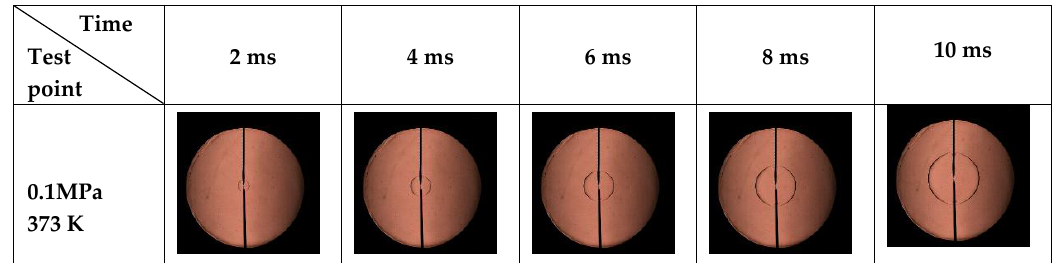
Figure A1. Schlieren photographs of flame propagation under di ff erent initial temperatures ( DR = 2%, Φ = 1.0).